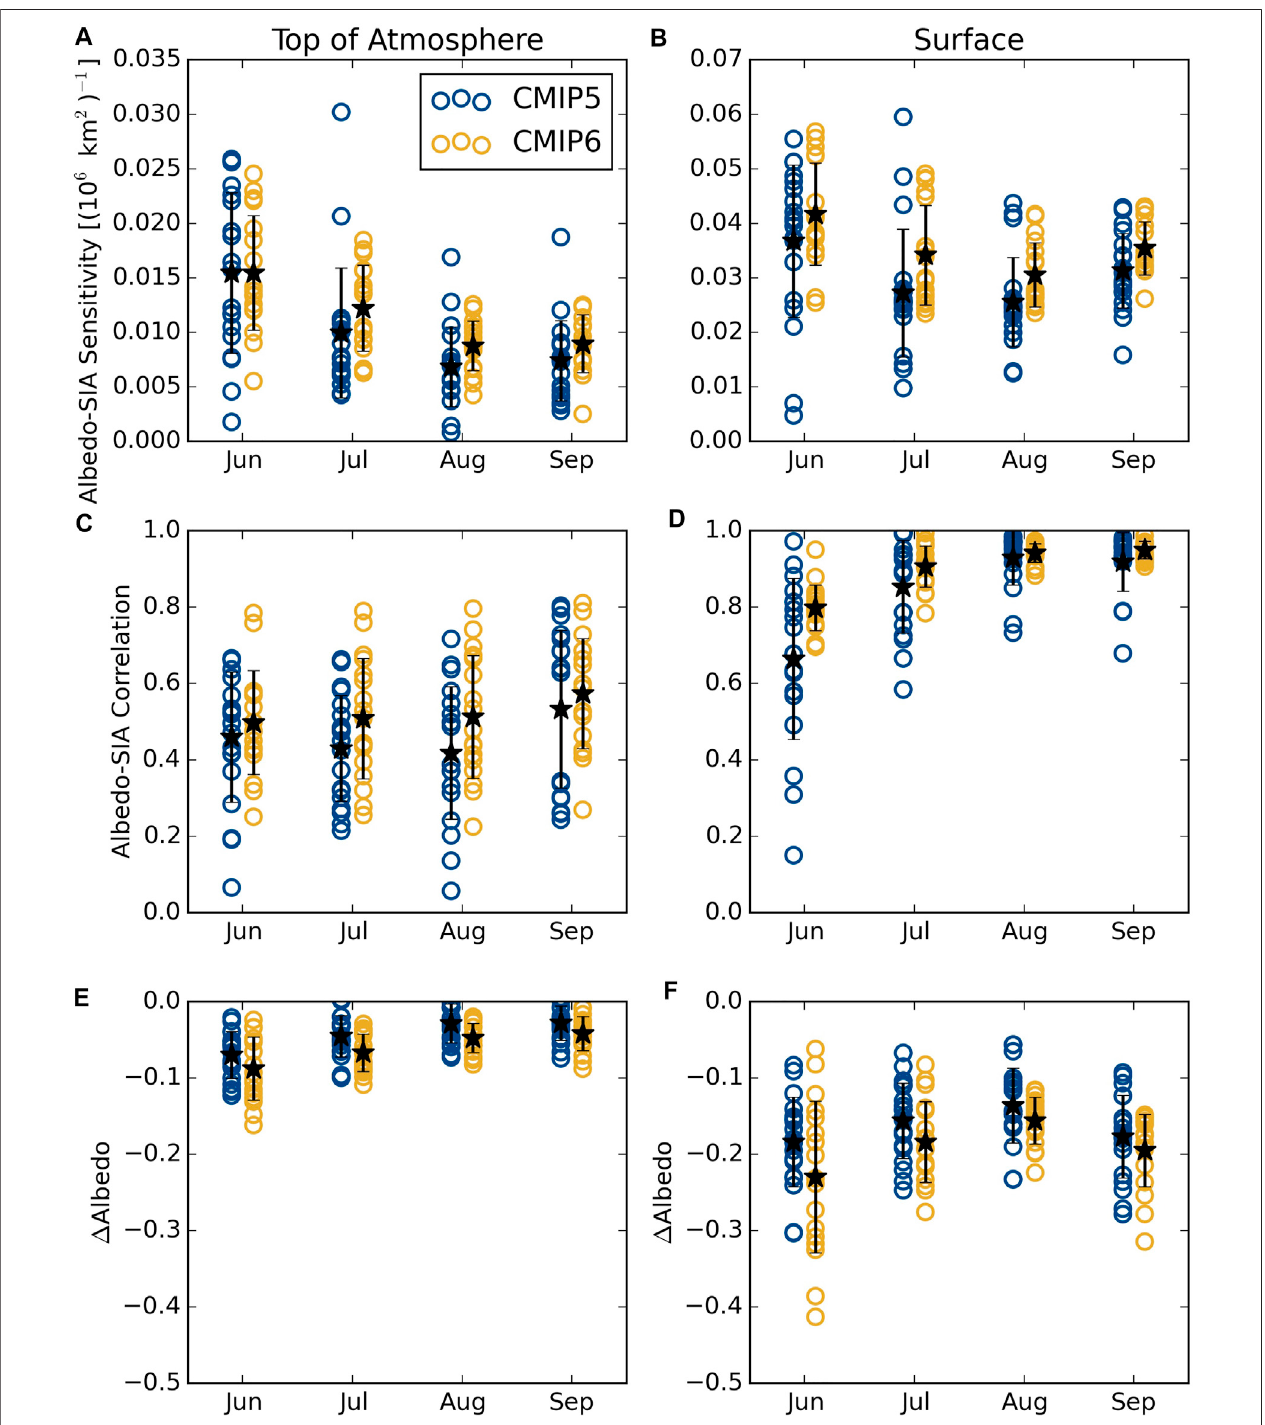
FIGURE 8 | Comparison of albedo-SIA sensitivities (A , B) and correlations (C , D) at the top of the atmosphere (A , C) and surface (B , D) . Values are calculated over 1900 – 2005 from CMIP5 and CMIP6. Changes over the 21st century ([2080 – 2100] minus [1900 – 2005]) are also shown for the TOA albedo (E) and surface albedo (F) . Ensemble means are shown as stars for each